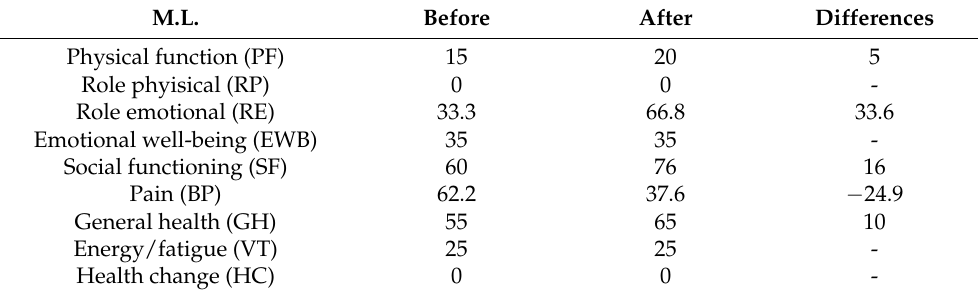
Table 4. Trend of the